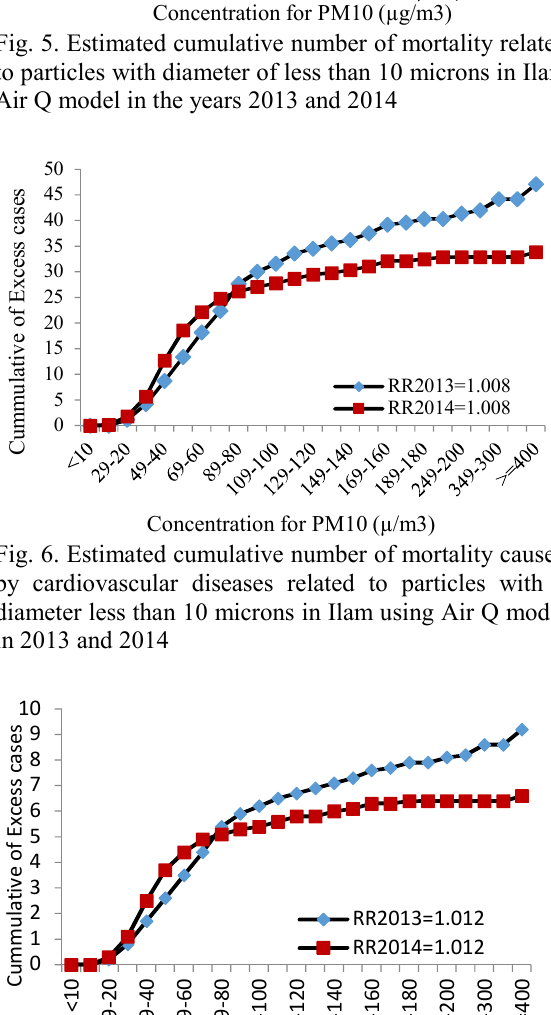
Fig. 8. Estimates total cumulative number of hospital admissions for respiratory disease related to particles with a diameter less than 10 microns in Ilam using Air Q model in 2013 and 2014